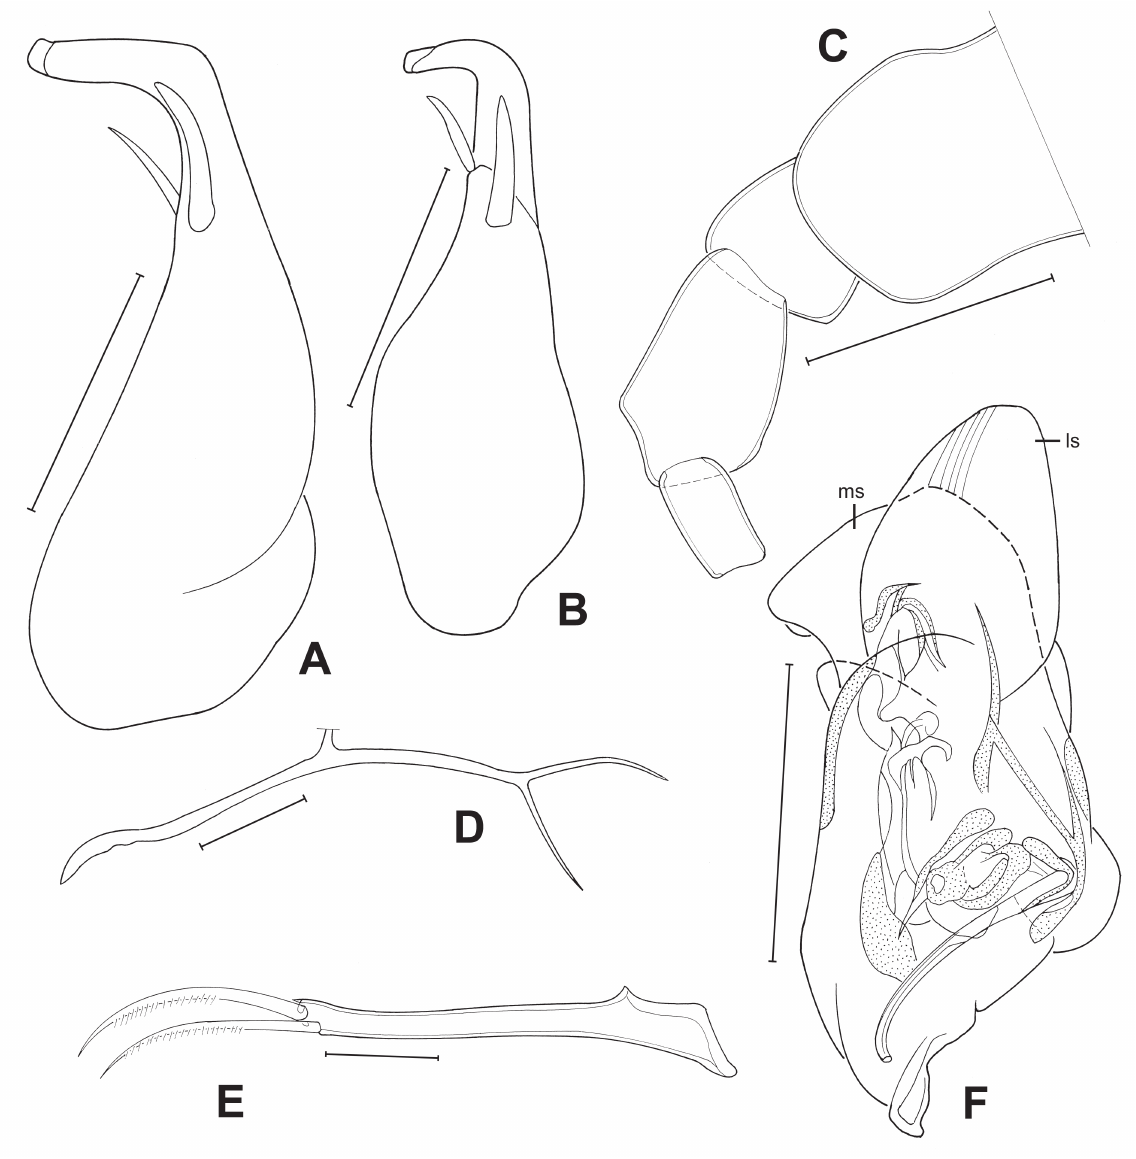
Fig. 11. Limbs of Candobrasilopsis elongata sp. nov. (♂). A . Left prehensile palp (MZUSP 32685). B . Right prehensile palp (MZUSP 32685). C . Md palp (MZUSP 32685). D . Attachment of the caudal ramus (MZUSP 32685). E . Caudal ramus (MZUSP 32685). F . Hemipenis (MZUSP 32685). Scale bars: A–E = 50 µ m; F = 100 µ m